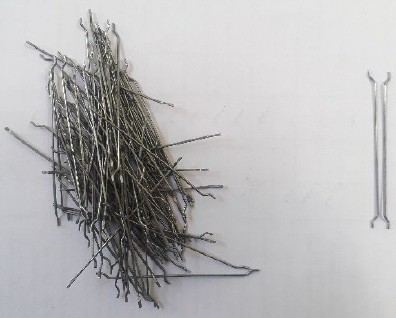
Figure 1. Fibre used in this study.